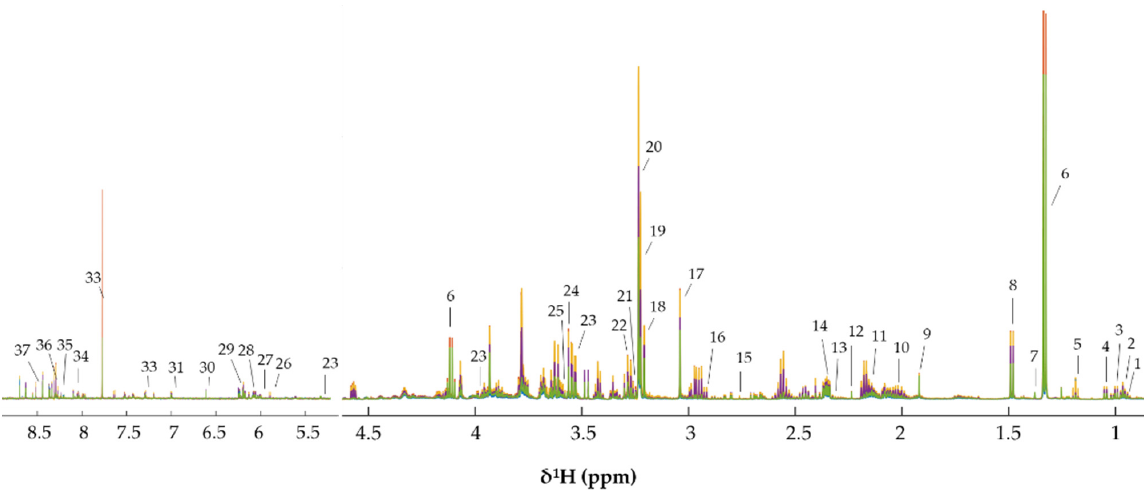
Figure 4. 1 H-NMR spectra of the intracellular metabolites of KKU-100 and KKU-213 cells. Key metabolites: (1) isovalerate (2) leucine (3) isoleucine (4) valine (5) ethanol (6) lactate (7) dimethylmalonic acid (8) alanine (9) acetate (10) homocysteine (11) proline (12) oxaloacetate (13) succinate (14) glutamate (15) dimethylamine (16) glutathione (17) creatine (18) choline (19) phosphocholine (20) carnitine (21) betaine (22) taurine (23) glucose (24) glycine (25) dihydroxyacetone phosphate (26) uracil (27) uridine (28) NAD + (29) ATP (30) fumarate (31) tyrosine (32) phenylalanine (33) guanine (34) guanosine (35) adenine (36) inosine (37) formate.